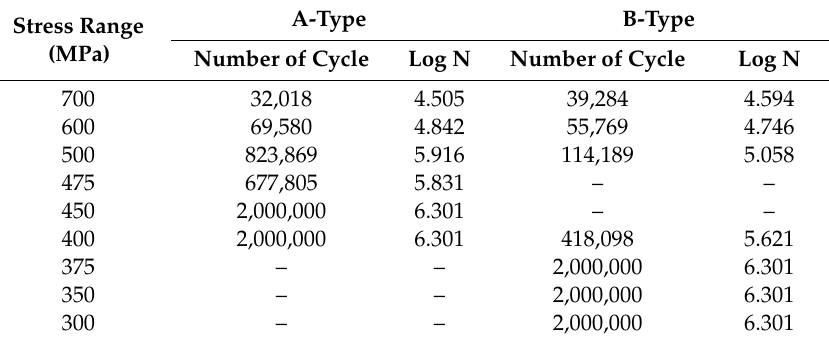
Figure 5. Test specimens after fatigue tests. ( a ) A-type; ( b ) B-type. Table 3. Summary of fatigue test results.